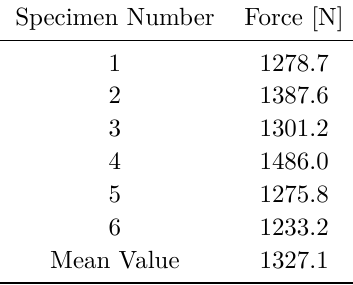
Table 1. Maximum static load force for all EH spec- imens.